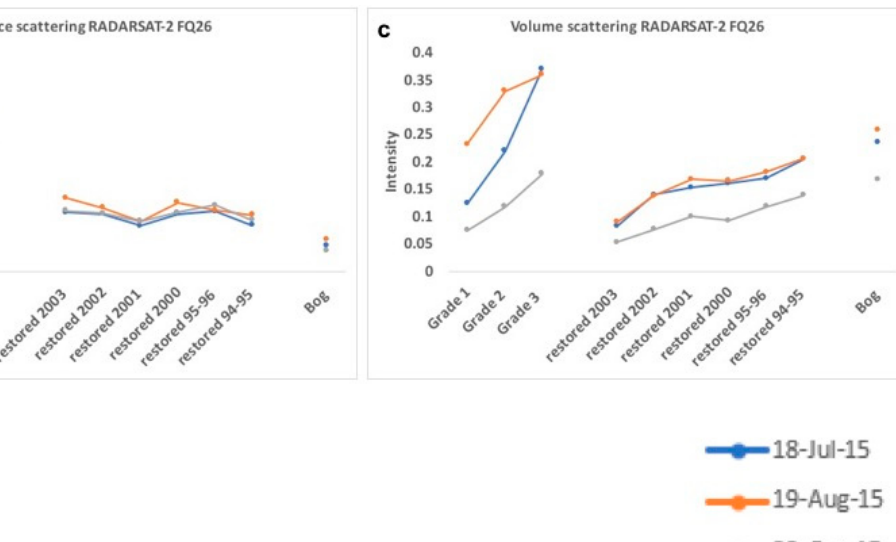
Figure 7. Graphs show the spectral signatures of natural shrub bog, harvested peat, and restored peat when the Freeman–Durden decomposition was applied to RADARSAT-2 FQ26 images. Double-bounce scattering is presented in ( a ), surface scattering in ( b ), and volume scattering in ( c ). All values are represented in decibels (dB).